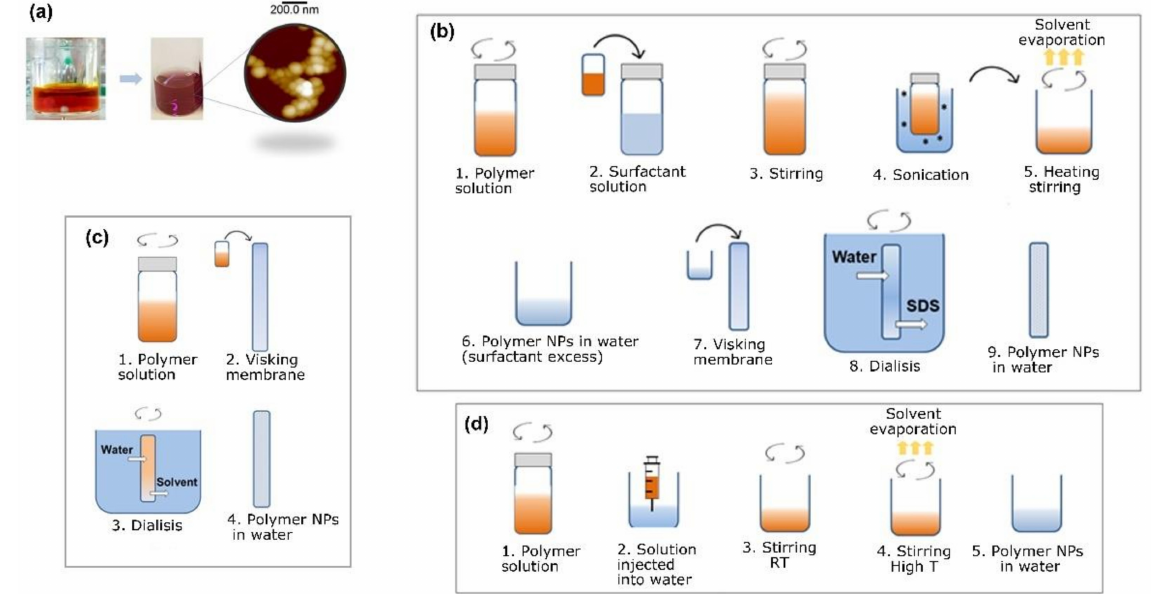
Figure 1. ( a ) Example of water-based ink preparation of poly(3-hexylthiophene-2,5-diyl) (P3HT). Starting from a P3HT solution in an organic solvent (red liquid), a water-based ink containing polymer nanoparticles is prepared (pink liquid). The detailed morphology of the polymer nanoparticles obtained by atomic force microscopy (AFM) is shown; ( b – d ) schematics illustrating the preparation steps for water-based inks of functional polymer nanoparticles by miniemulsion, dialysis nanoprecipitation, and flash nanoprecipitation,